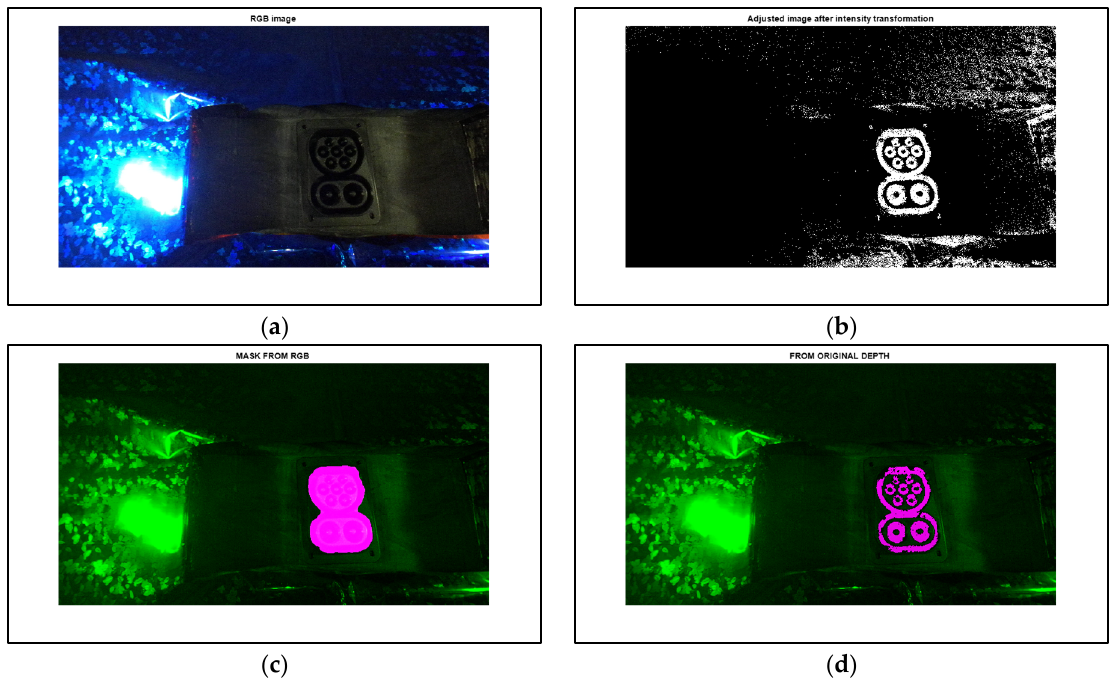
Figure 16. ( a ) Input RGB image, ( b ) result of the intensity transformation, ( c ) obtained binary mask, and ( d ) detected CCS2 connector.